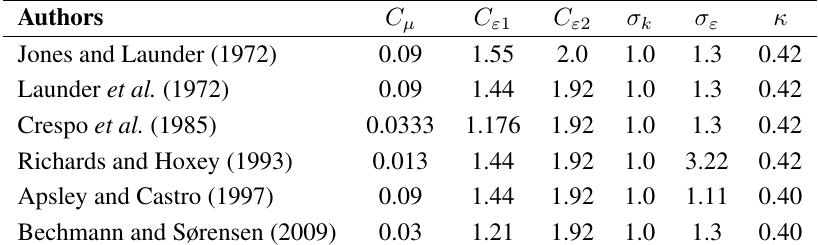
Table 1. A selection of proposed k − ε model